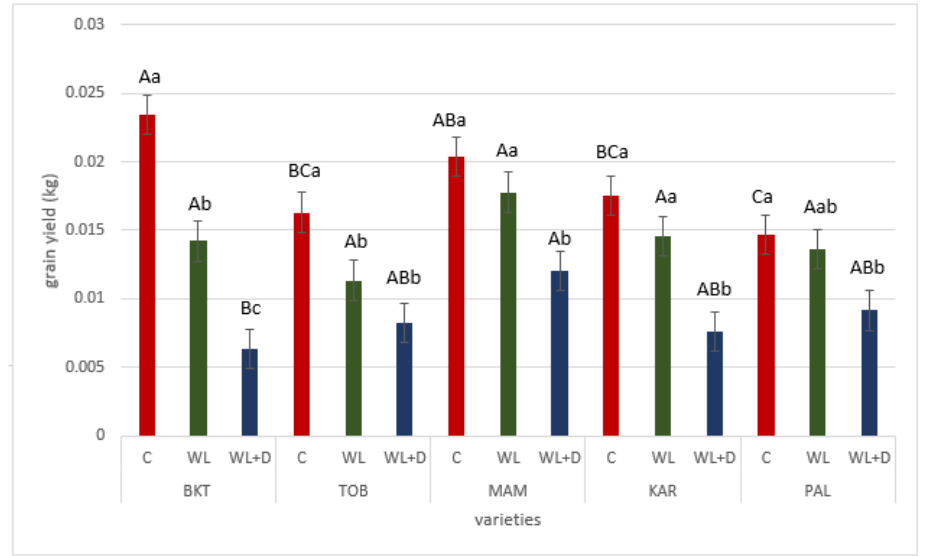
Figure 3. Grain yields of ‘Bánkúti 1201’ (BKT), ‘Mv Toborzó’ (TOB), ‘Mv Mambó’ (MAM), ‘Mv Karizma’ (KAR) and ‘Mv Pálma’ (PAL) varieties in the different treatments. ‘C’: control treatment; ‘WL’: waterlogging treatment; ‘WL + D’: combined treatment of waterlogging and drought. Capital letters indicate the statistical significance between the varieties at P ≤ 0.05 level; lowercase letters indicate the statistical significance between the treatments at P ≤ 0.05. Error bars represent honestly significant difference (HSD) 5% values (n = 3).